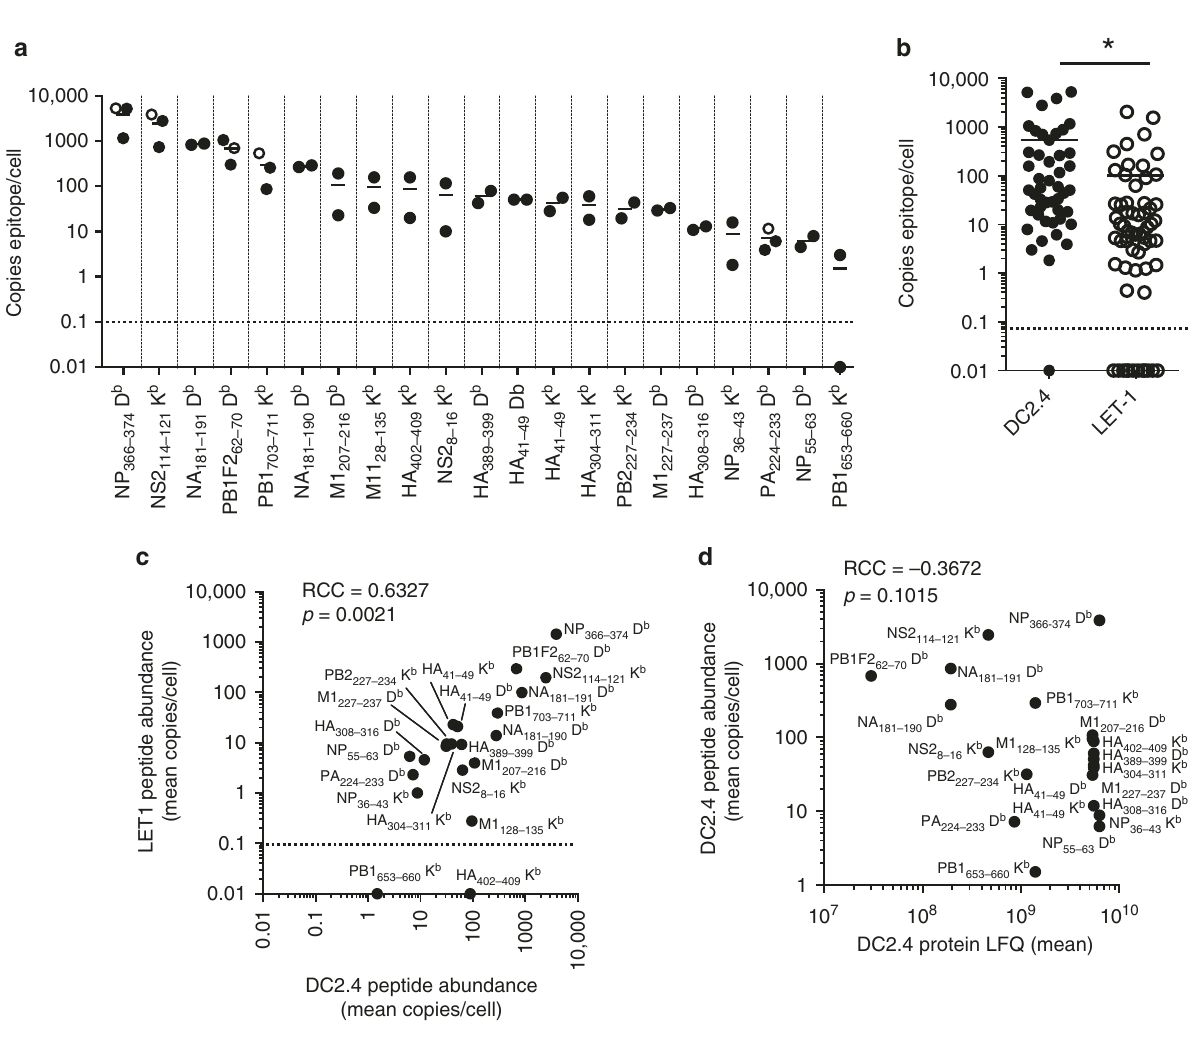
(85%) of the peptides bound either H-2K b or D b , or both with an af fi nity of 500 nM or better, an af fi nity threshold identi fi ed for the